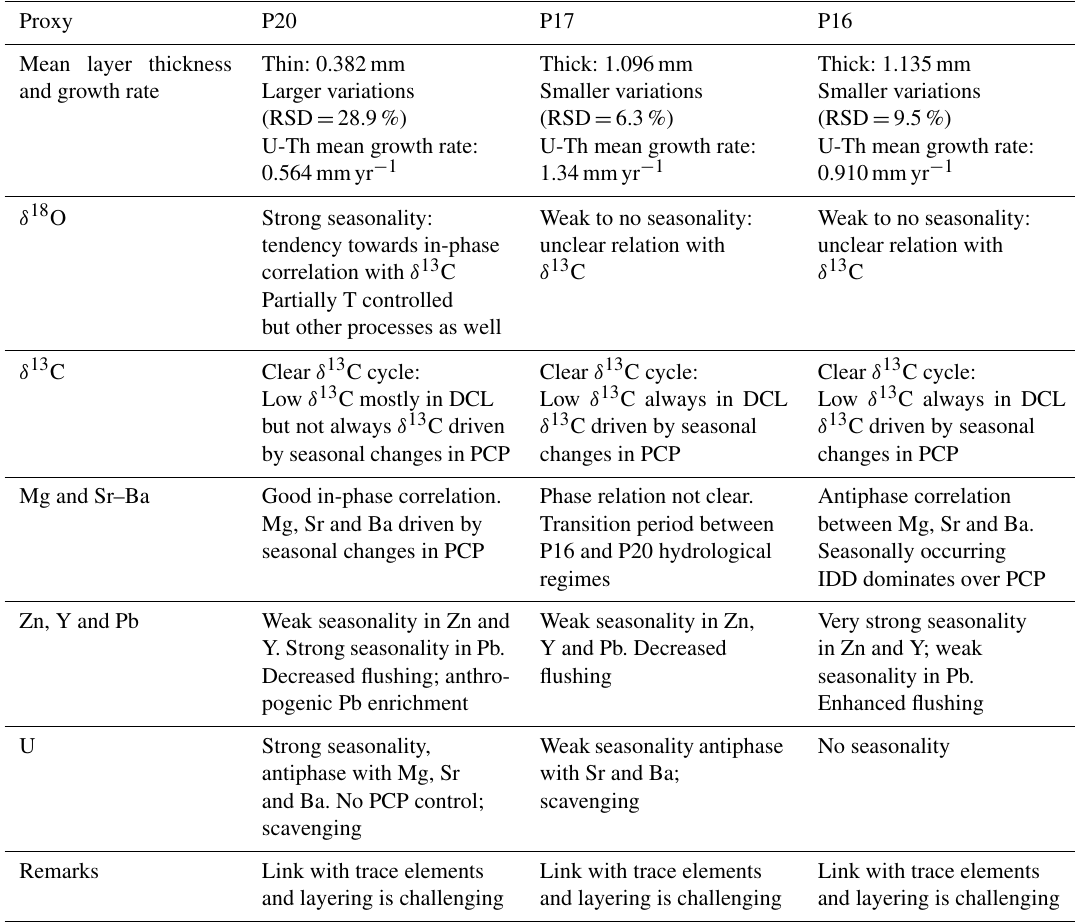
Table 1. Schematic overview providing the observed changes and interpretation for the different proxies of P20, P17 and P16. PCP represents prior calcite precipitation, IDD represents incongruent dissolution of dolomite, DCL represents dark compact layers, and WPL represents white porous